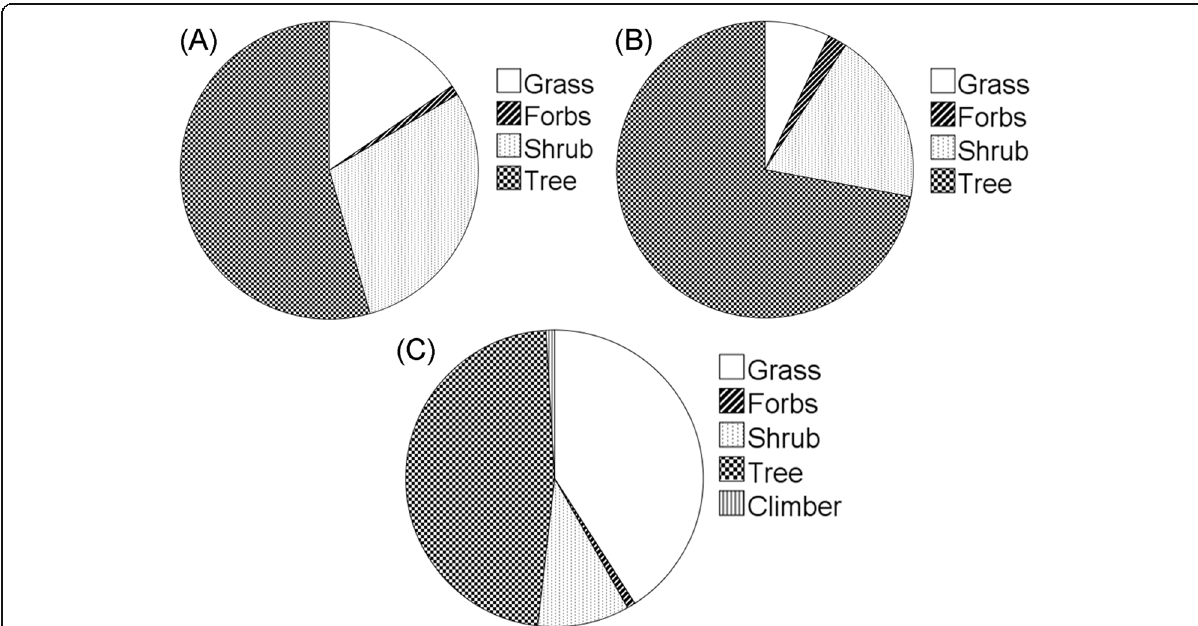
Fig. 3 Seasonal composition (%) of different plant categories in the four-horned antelope ( T. quadricornis ) diet in the tropical deciduous forests of southern Rajasthan, India ( a , winter; b , summer; c , monsoon)